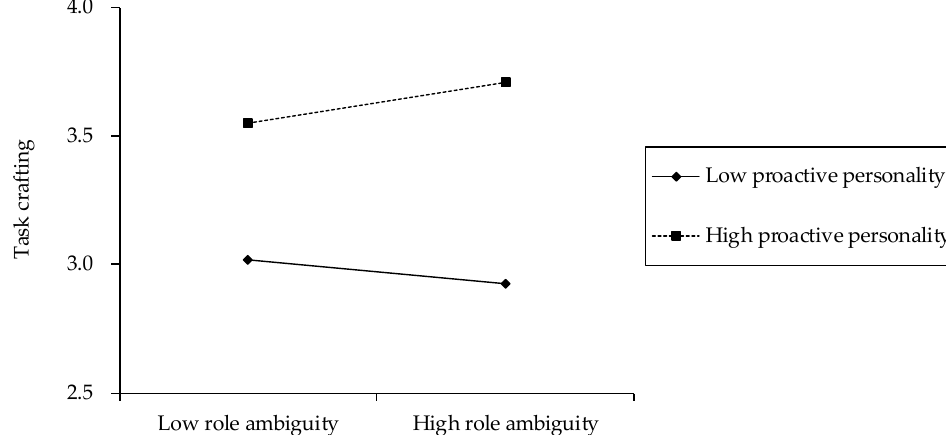
Figure 3. The moderating effect of proactive personality on the relationship between role ambiguity and task crafting.